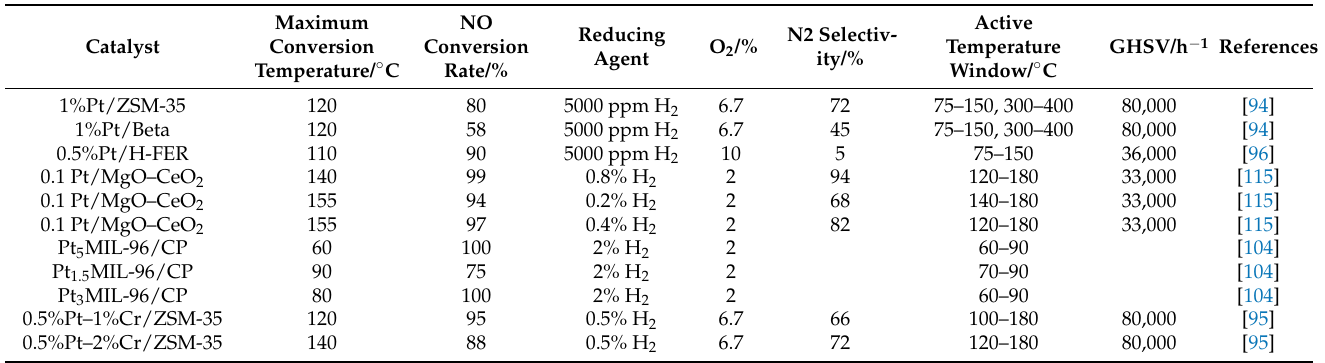
Figure 8. Possible mechanism of H 2 +NO reaction over ( a ) Co/VSB-15 and ( b ) Pd(111) catalysts. Table 3. Catalysts for catalytic reduction of NO x by H 2 under different